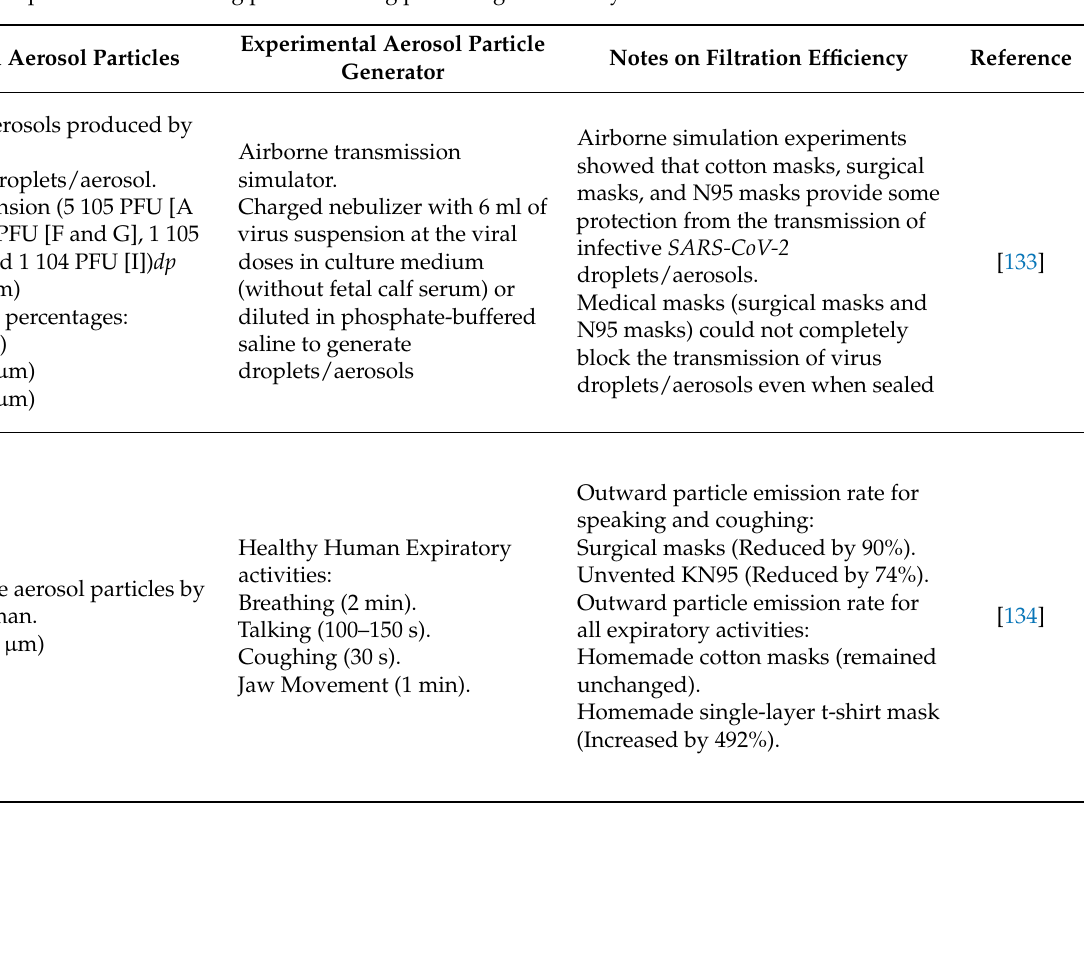
Table 8. Summary of face mask and respirator filtration experiments and testing practices using particles generated by human